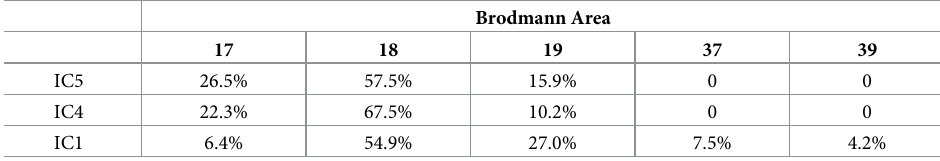
Table 3. Percentage of brain activations at each Brodmann area (sum of all voxels whose activation was greater than 75% of the maximum of whole brain activation) for IC5, IC4, and